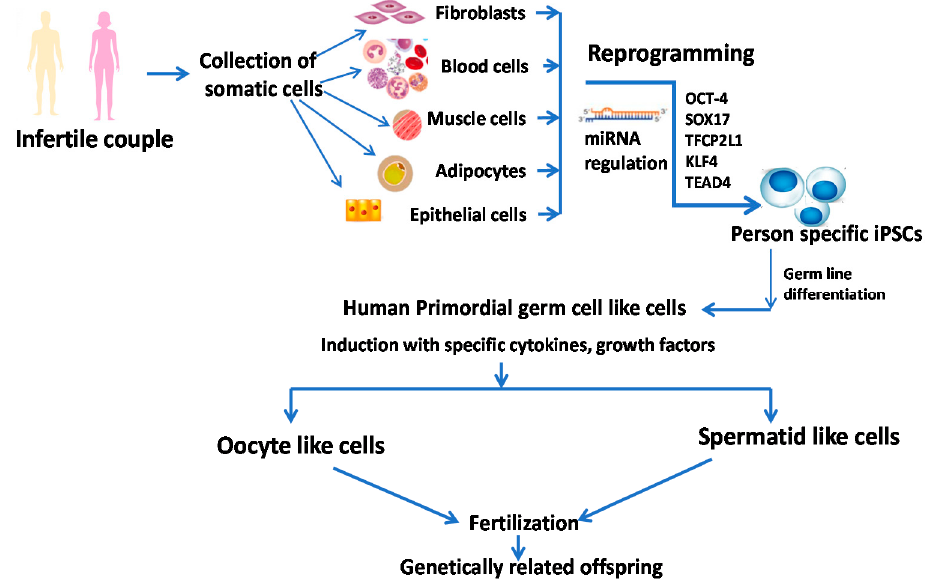
Figure 2. The role of stem cells in the generation of patient-specific gamete cells. TEAD4: trophecto- derm regulator TEA domain transcription factor 4; SOX17: endoderm regulator SRY-box 17; TFCP2L1: pluripotency factors transcription factor CP2-like 1; KLF4: Kruppel-like factor 4; miRNA: Micro RNA; OCT-4: octamer-binding transcription factor 4. Modified from references. [35,57,60]